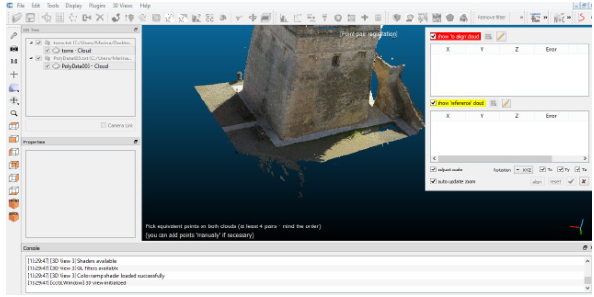
Figure 11: CloudCompare, registration and alignment of points Each point of the cloud will be coloured as a function of its value, according to the chosen colour scale.